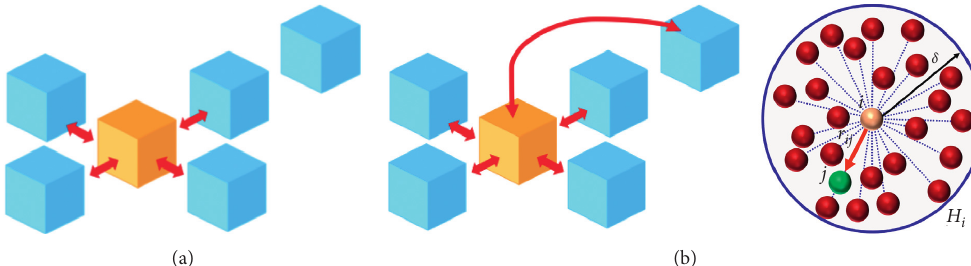
Figure 1: Representations of local and nonlocal interaction: (a) local theory; (b) nonlocal theory.